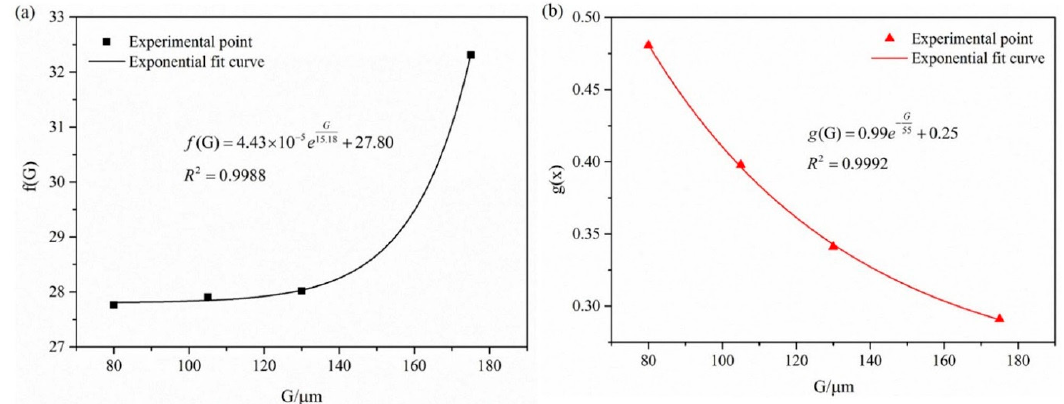
Figure 11. Fitting curves for ( a ) f (G) and ( b ) g (G).